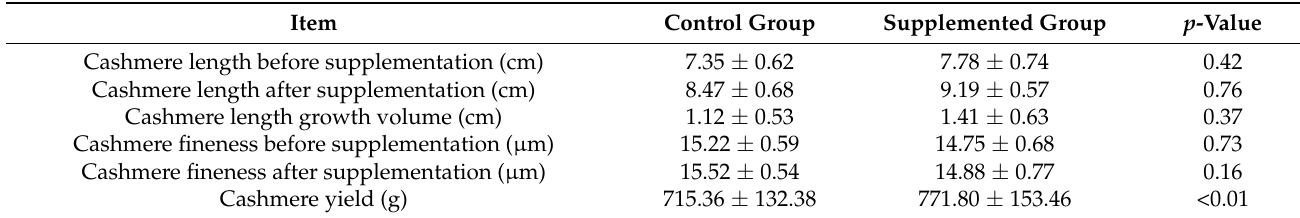
Table 4. Effect of supplementary feeding on cashmere production performance.